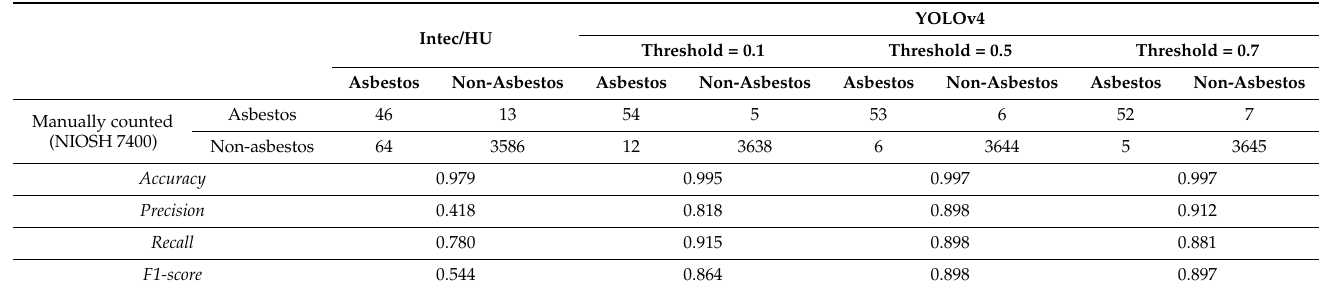
Table 2. Confusion matrix of the testing